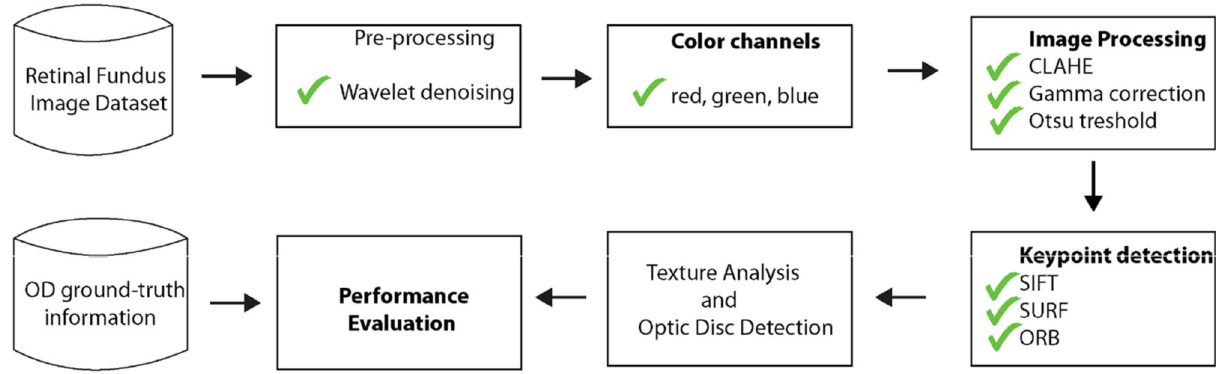
Fig. 2 The flowchart of the proposed approach